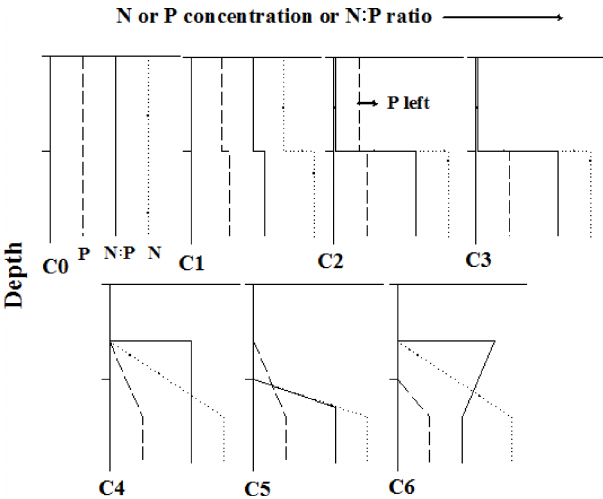
Figure 1. Conceptual model for changes in vertical profiles of N, P and N:P ratio due to sequential nutrient uptake. C0 to C3 represent a time series of nutrient uptake during bloom development, and C4 to C6 indicate subsequent vertical mixing of nutrients and subse- quent uptake. The short horizontal line near the middle of the depth axis indicates the euphotic zone depth. N disappears first at C2, and P is left and continues to be taken up at C3. C4 represents mixing of nutrients into the bottom of the photic zone and phytoplankton have not taken up these nutrients yet. At C5, N is taken up first before P, while at C6, P is taken up first before